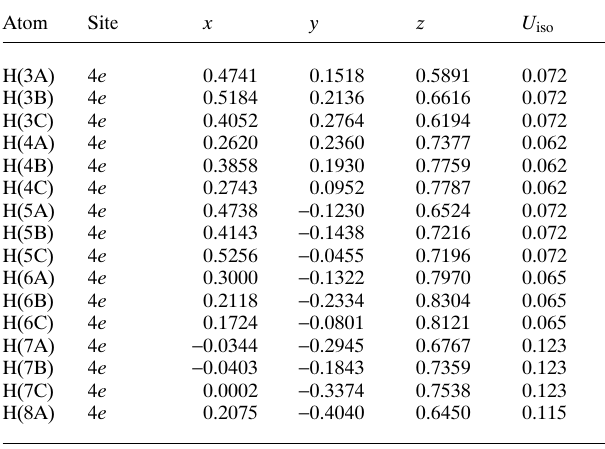
Table 2. Atomic coordinates and displacement parameters (in Å 2 )